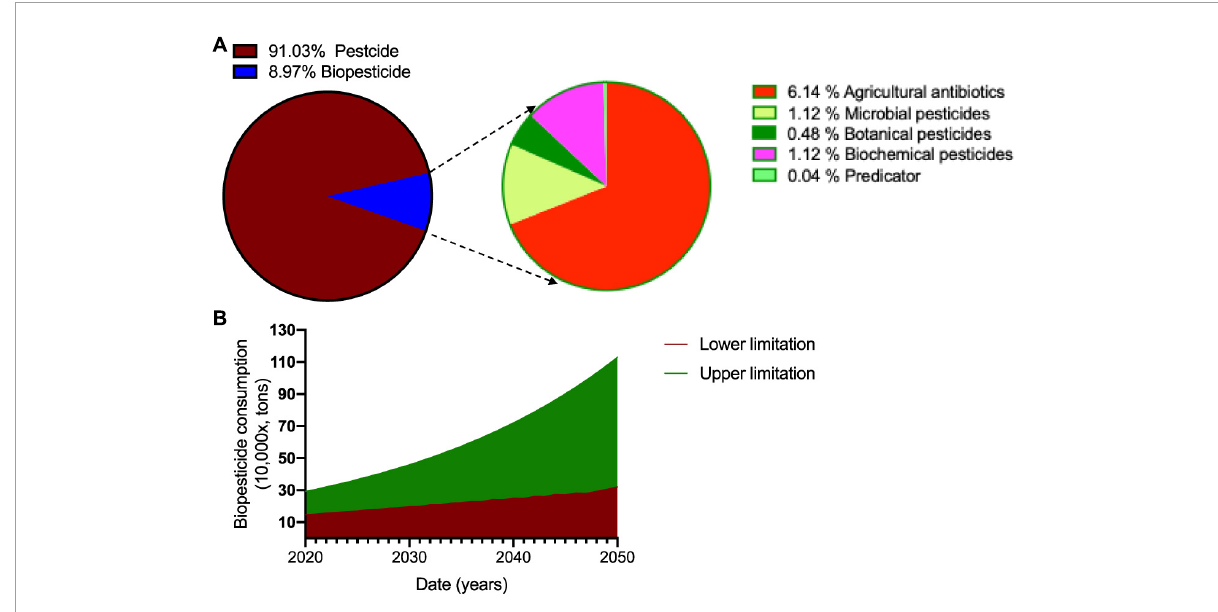
FIGURE4 The development of biopesticide in China. (A) The proportion of biopesticides to the proportion of chemical pesticides in China in 2020. (B) The development of biopesticide in China until 2050 based on CAGR calculation. CAGR, compound annual growth